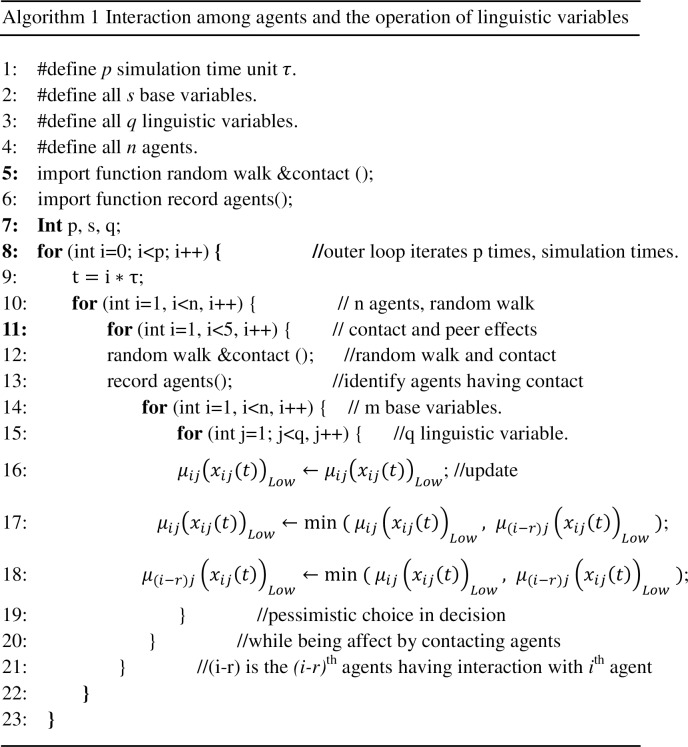
Pseudo code for the interactions among agents and the operations of linguistic variables.